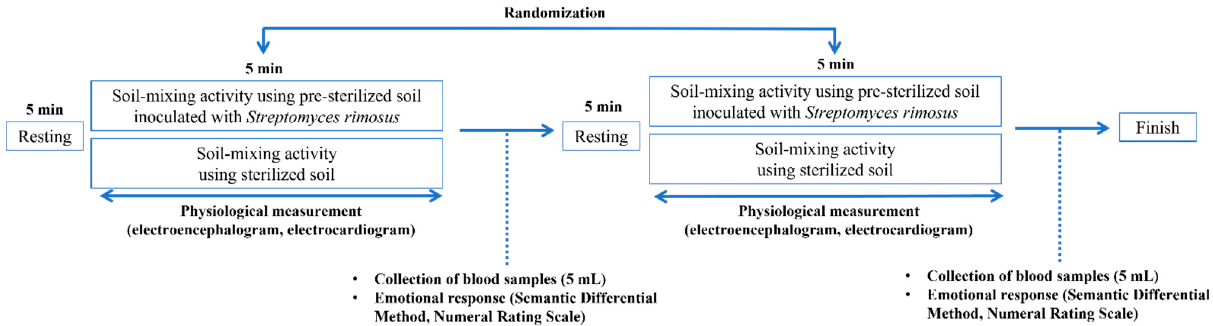
Figure 3. Experiment protocol. EEG: electroencephalogram; SDM: comparisons via the Semantic Differential Method; Stress: subjective stress evaluation (NRS: numeral rating scale). Differential Method; Stress: subjective stress evaluation (NRS: numeral rating